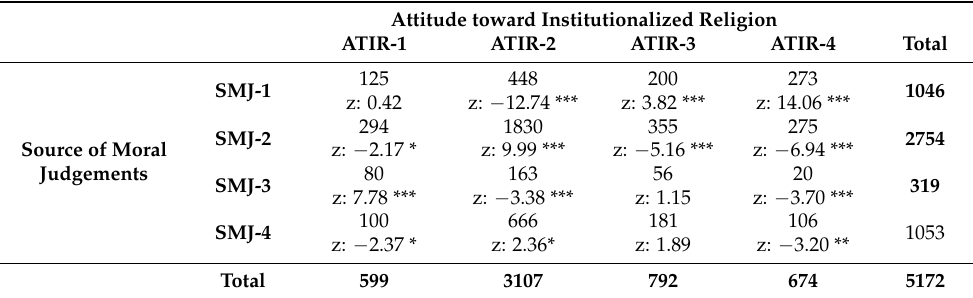
Table 8. Relationship between the attitude toward institutionalized religion (ATIR) and source of moral judgements (SMJ). Source of Moral Judgements